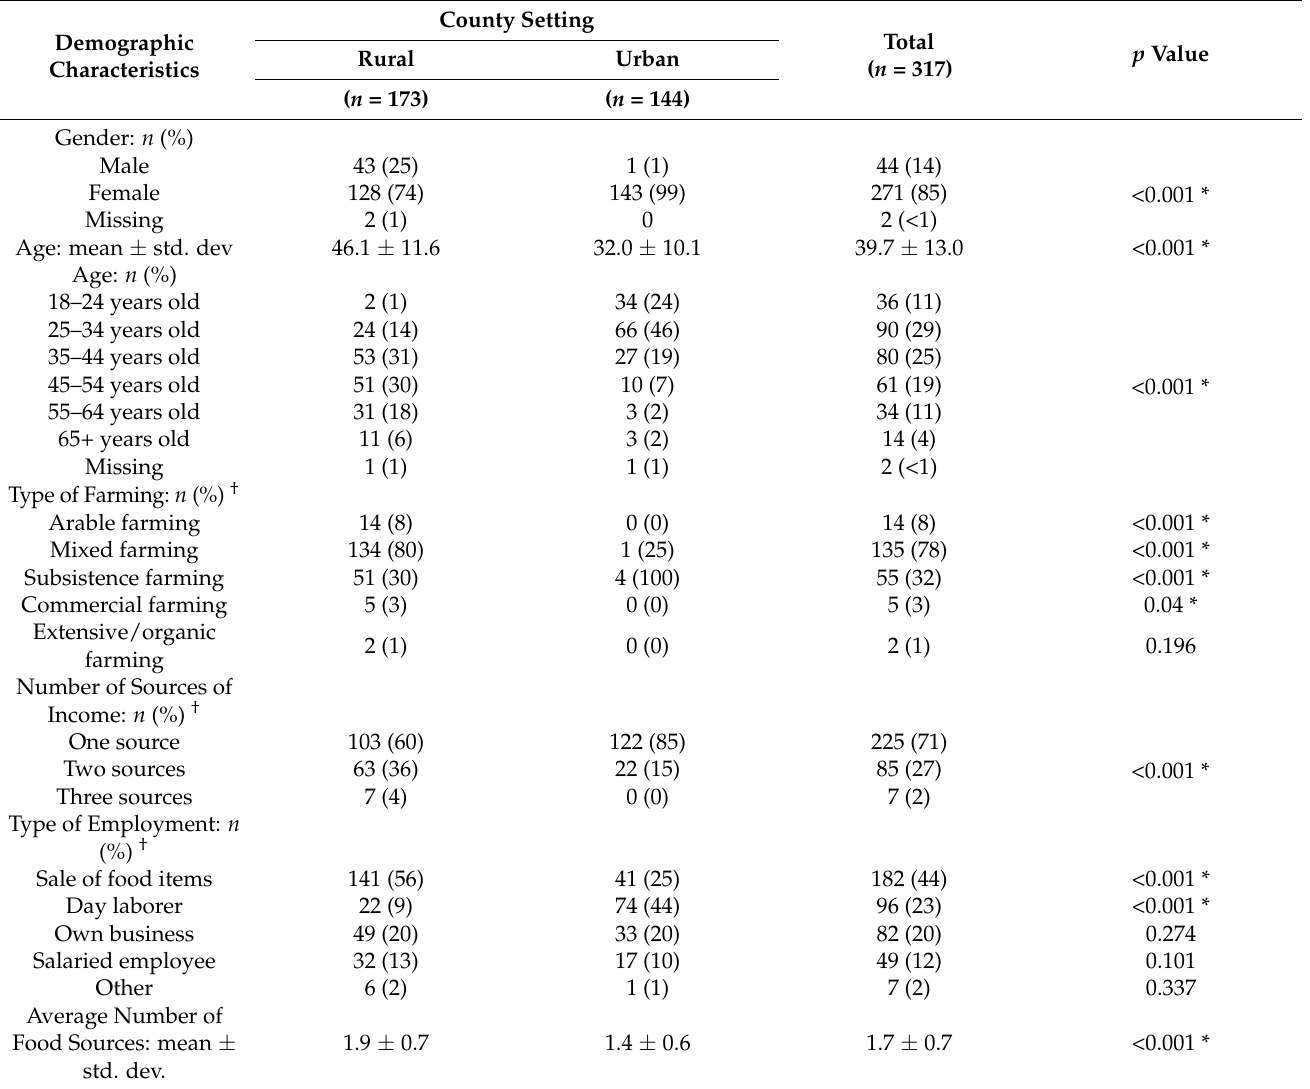
Table 1. Demographic data from telephonically surveyed households belonging to rural communities in Western Kenya and an urban informal settlement (Mukuru) in